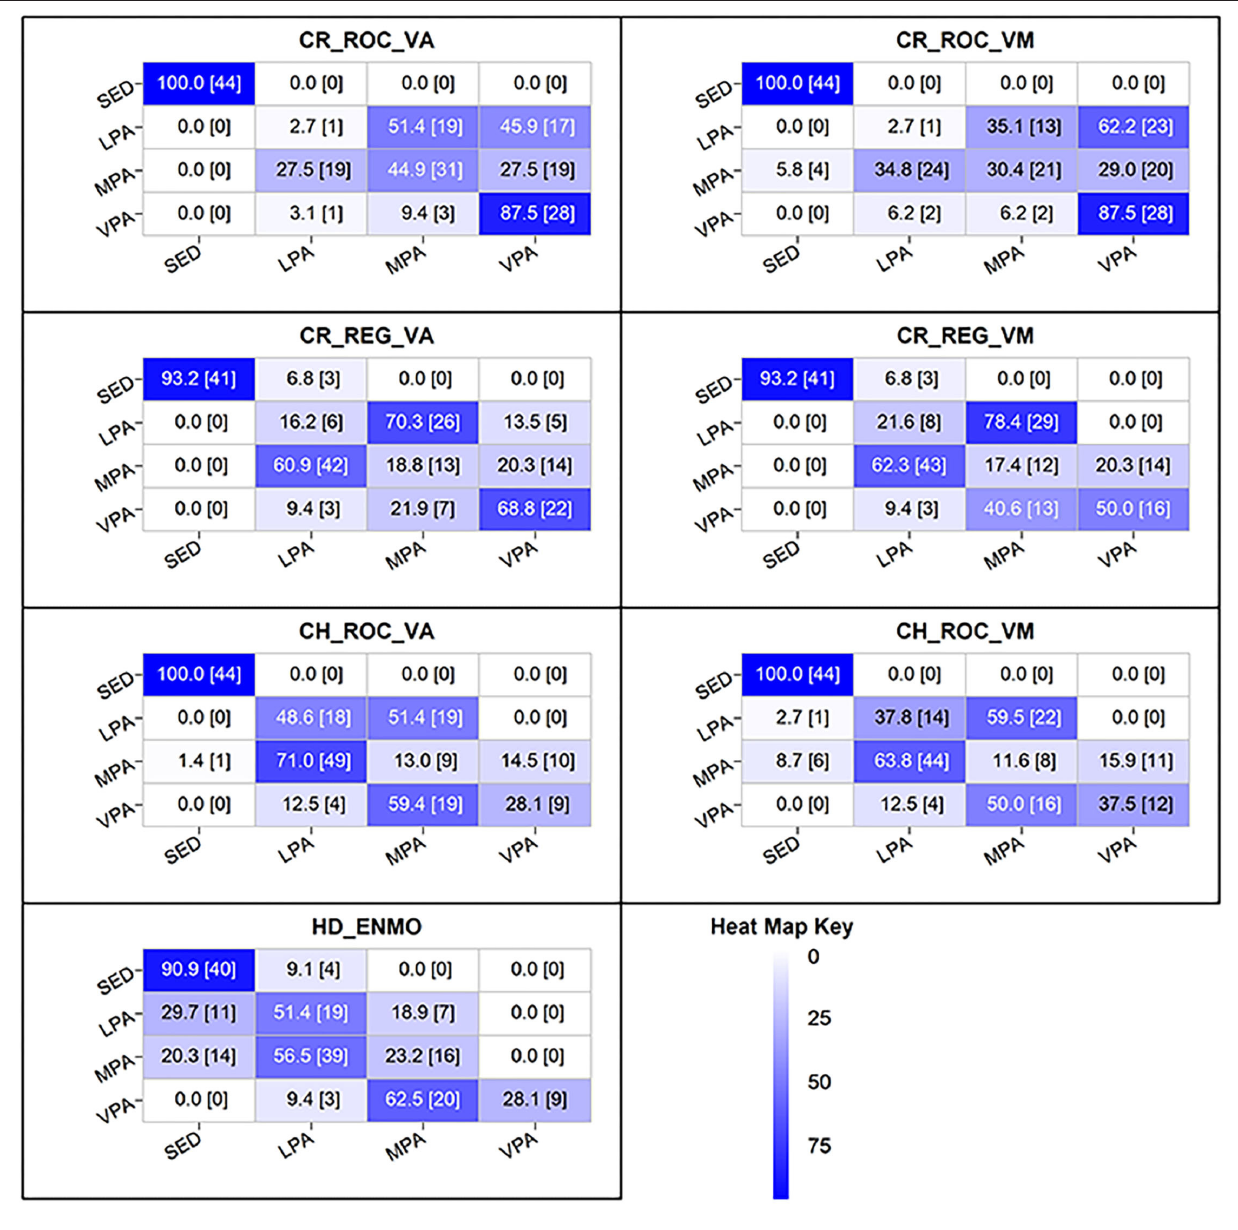
activities at the high end of the intensity spectrum (basketball, running), the cut-points consistently underestimated physical activity intensity. The exception to this pattern was the Crouter ROC cut-points, which overestimated the intensity of a small percentage (7%) of the basketball and running activities. As noted above, all seven sets of cut-points correctly classified the intensity of sedentary activities (lying down, handwriting, and